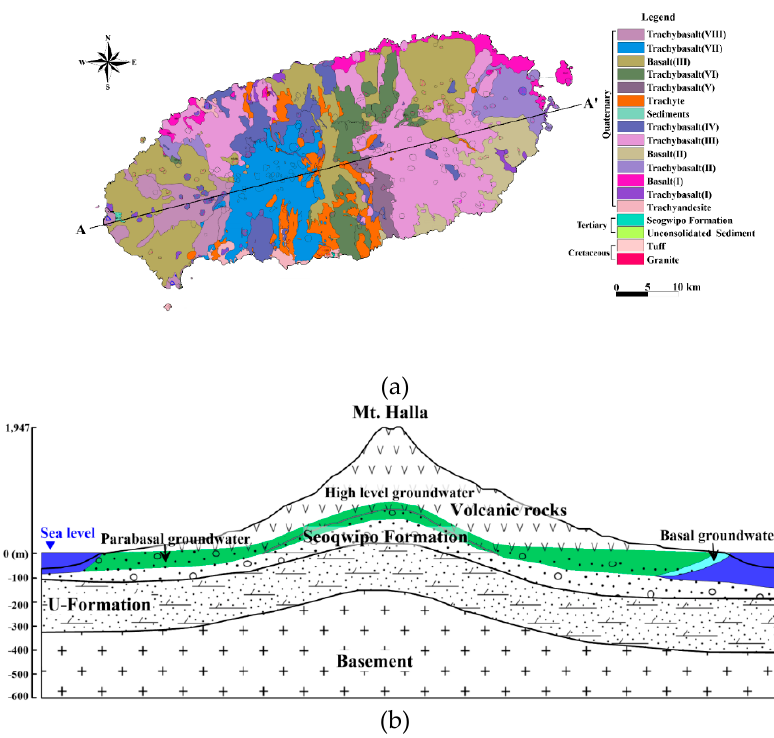
Figure 2. Geologic map ( a ) and simplified geologic cross section (A–A’) including three aquifer types of groundwater ( b ) of Jeju Island [4,10].